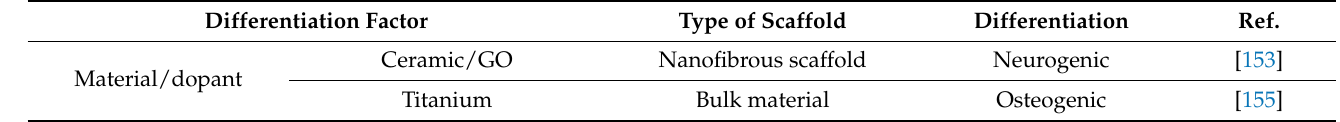
Table 5. Influence of ceramics and metals on cell